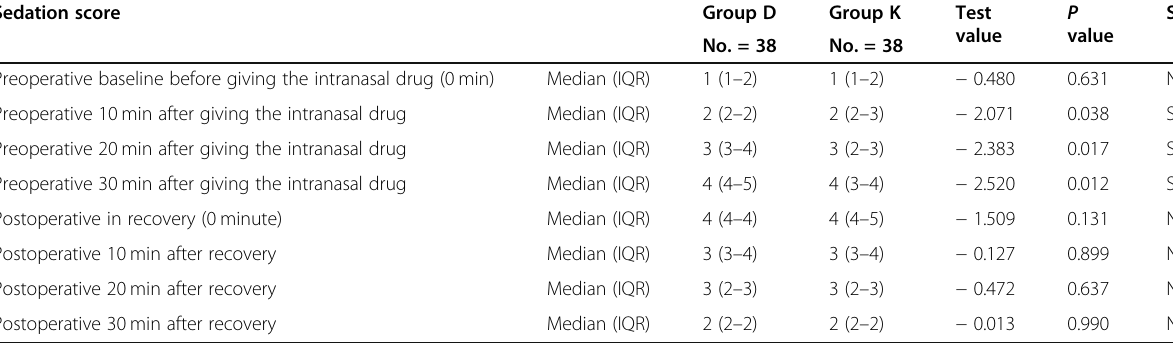
Table 10 Comparison between group D and group K as regards modified Ramsay sedation score Sedation score